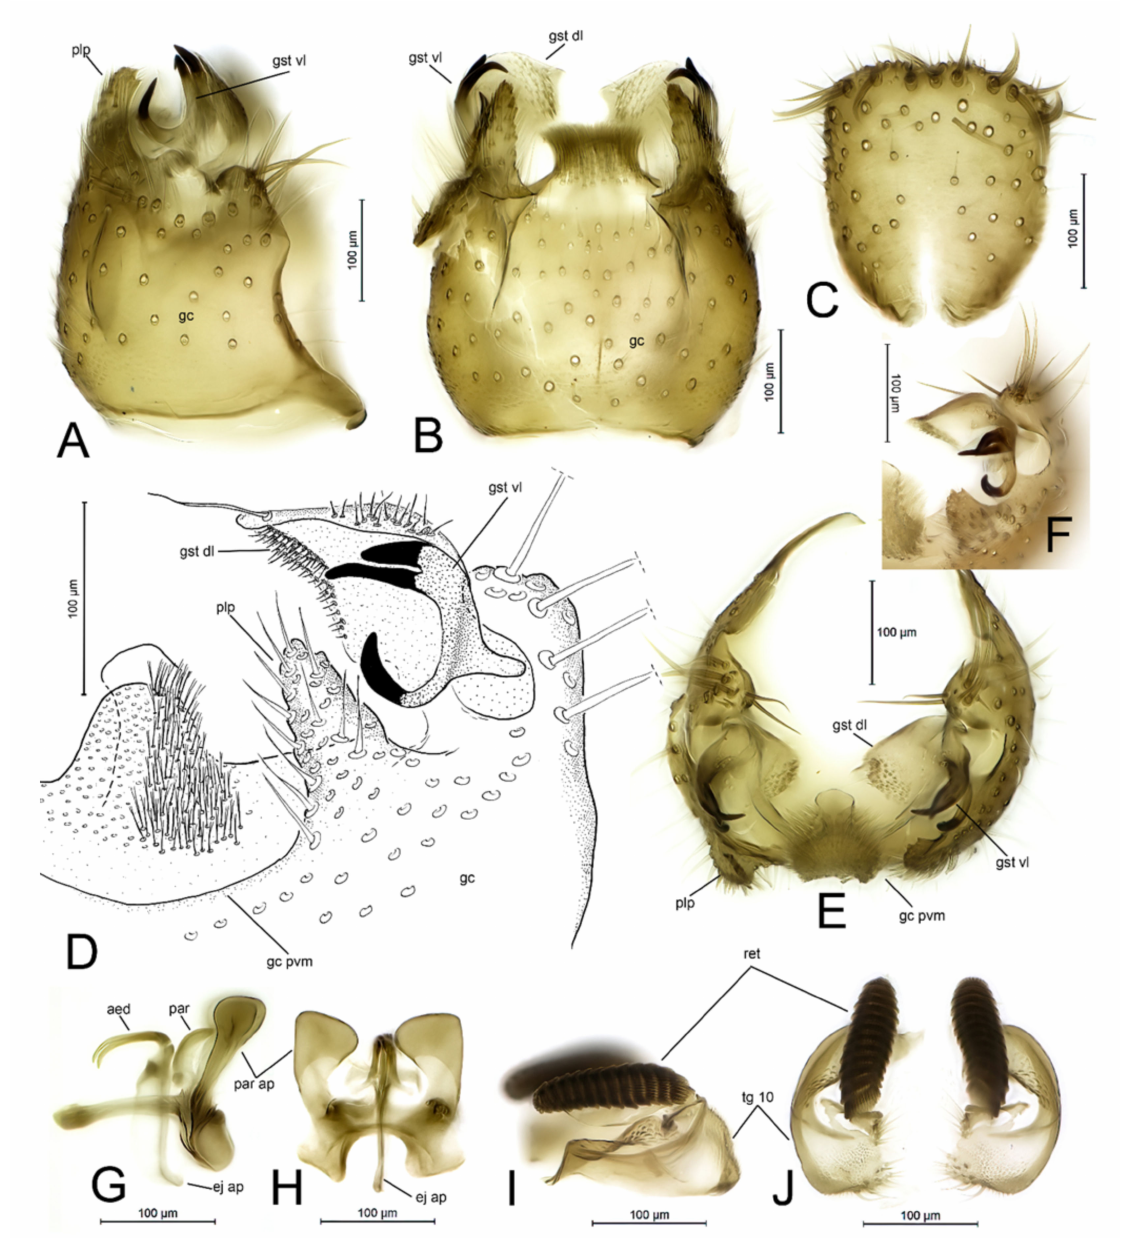
Figure 2. Docosia caucasica sp. n., [ZFMK-DIP-00082491], terminalia. ( A ) Lateral view; ( B ) Ventral view; ( C ) Dorsal view of ♂ tergite 9; ( D ) Postero-ventral view of gonostylus and gonocoxite; ( E ) Posterior view; ( F ) Postero-ventral view of gonostylus; ( G ) Lateral view of aedeagal complex; ( H ) Ventral view of aedeagal complex; ( I ) Lateral view of cerci; ( J ) Dorsal view of cerci. Abbreviations: aed = aedeagus; ej ap = ejaculatory apodeme; gc = gonocoxite; gc pvm = posteroventral margin of gonocoxite; gst vl = ventral lobe of gonostylus; gst dl = dorsal lobe of gonostylus; par = paramere; par ap = parameral apodeme; plp = posterolateral process of gonocoxite; ret = combs of retinacula. Description . Male ( n = 1). Length of wing 2.7 mm; ratio of length to width 2.67. Head blackish brown with numerous pale setae. Three ocelli, the laterals separated from the eye margins by approximately their own diameter. Mouthparts light brownish. Palpus with two basal segments brownish and three apical segments yellow. Scape, pedicel and all flagellomeres dark brown. Flagellomeres cylindrical, flagellomeres 1– 13 about 1.6 times as long as broad, apical flagellomere conical, about 3.8 times as long as broad